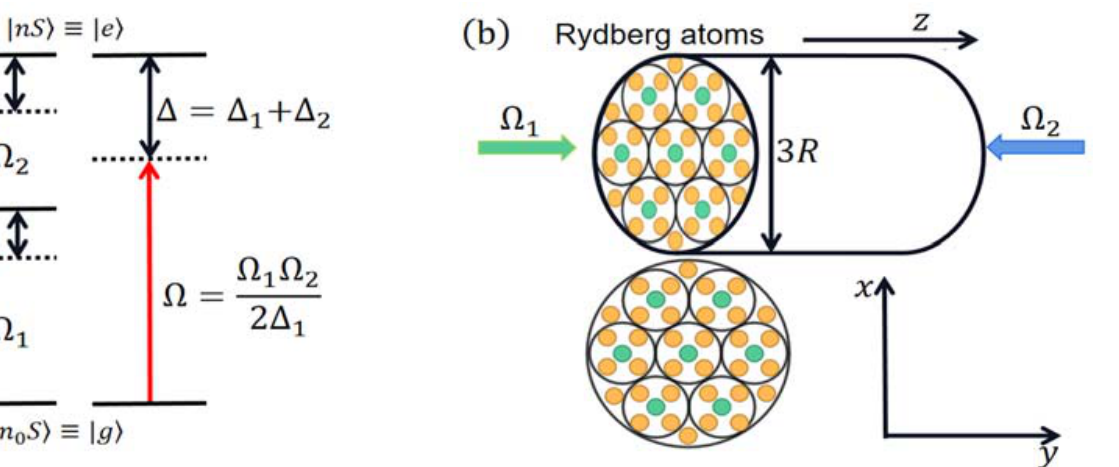
Figure 1. ( a ) Simplified level scheme of the considered Rydberg ‐ dressing approach. The off ‐ resonant coupling of condensed ground state ( | n 0 S > ≡| g > ) atoms to strongly interacting Rydberg